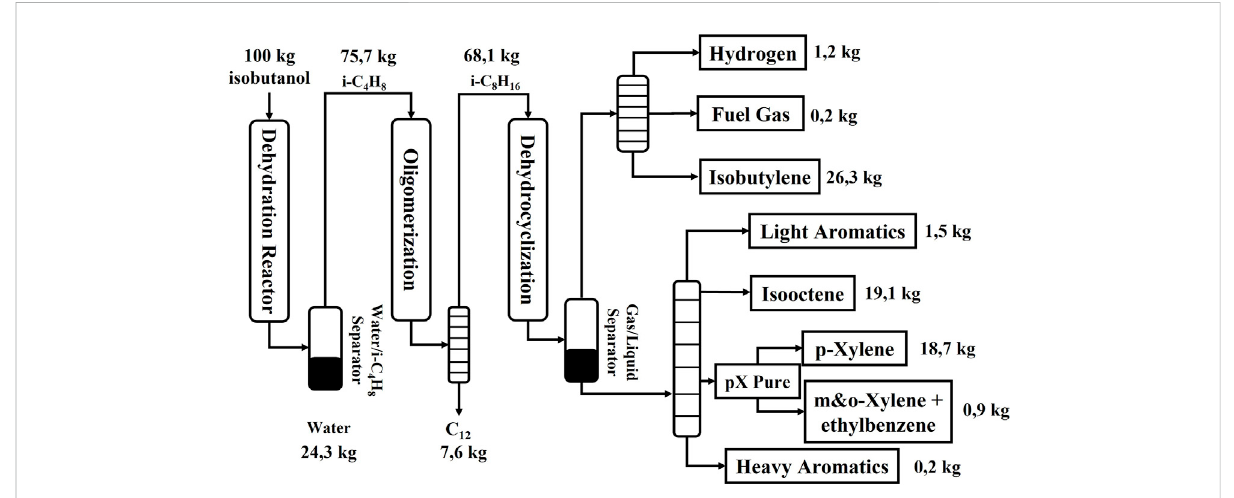
FIGURE 7 Process for the industrial conversion of 100 kg of isobutanol into p-xylene (from Peters et al.,